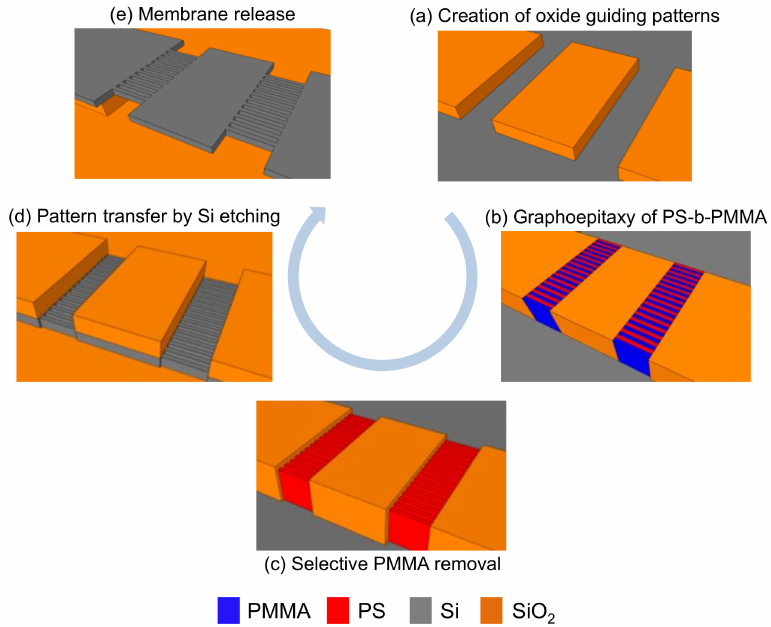
Figure 3. Main steps of the process flow developed for the fabrication of suspended SiNWs and membranes. ( a ) Silicon oxide GPs are created by EBL; ( b ) graphoepitaxy of PS-b-PMMA is performed in such a way that lamellae become perpendicular to walls and bottom of the trenches; ( c ) PMMA is selectively removed by dry etching; ( d ) remaining PS and SiO 2 are used as mask to define SiNWs and silicon membranes, respectively; ( e ) structures are released from the